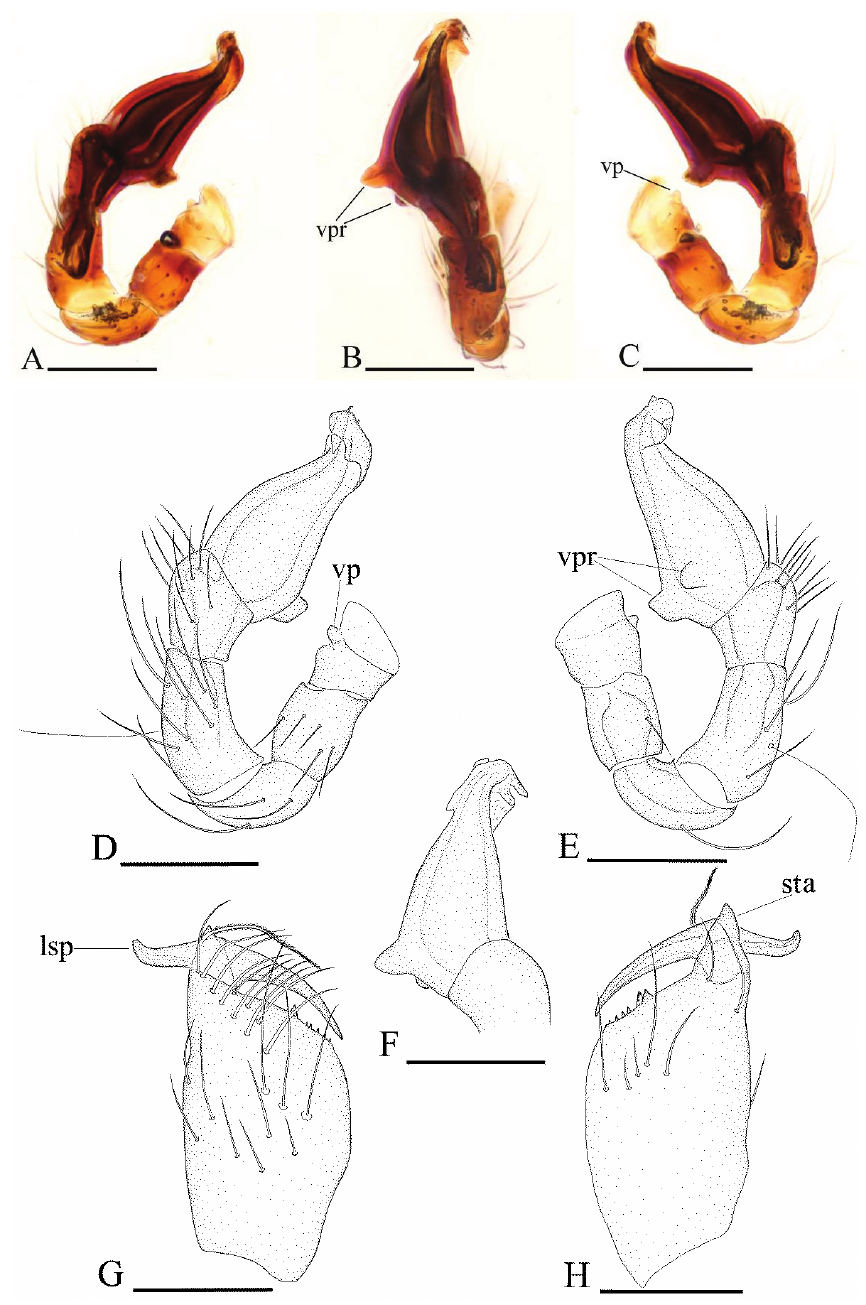
Figure 12. Ischnothyreus poculum sp. n., male. A, D left palp, prolateral view B, F left palpal bulb, dorsal view C , E left palp, retrolateral view G, H left chelicerae, anterior and posterior views. Abbreviations: lsp = long sclerotized process; sta = sclerotized triangular-shaped apophysis; vp = ventral projection; vpr = ventral protuberance. Scale bars: 0.1